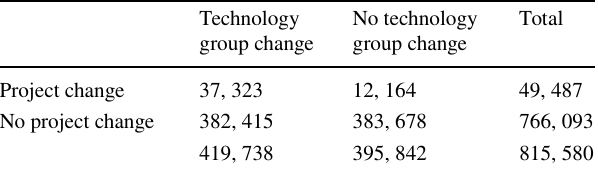
Table 6 Contingency table to test whether project change and tech- nology group are